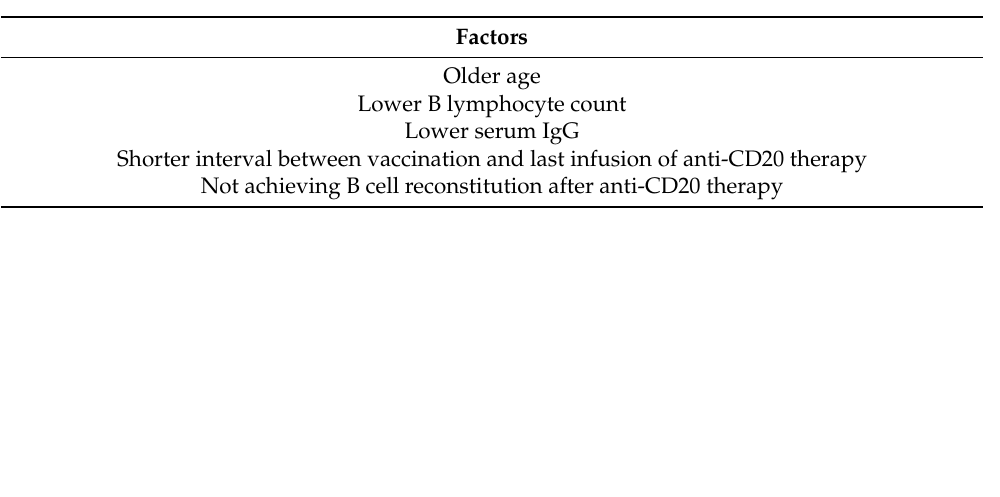
Table 2. Factors other than medication use that were associated with a lower seroconversion rate after COVID-19 vaccination in rheumatic